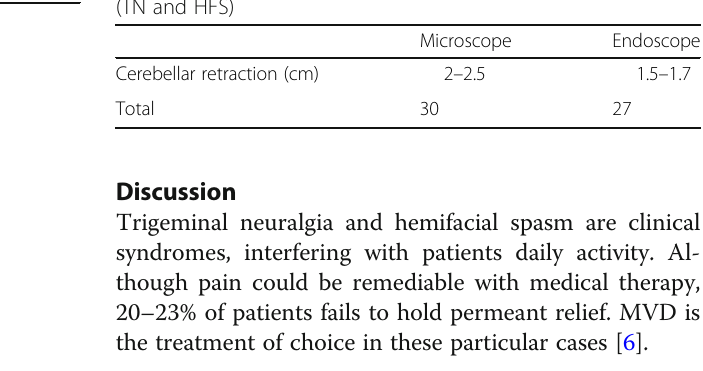
Table 2 Operative data of patients with TN